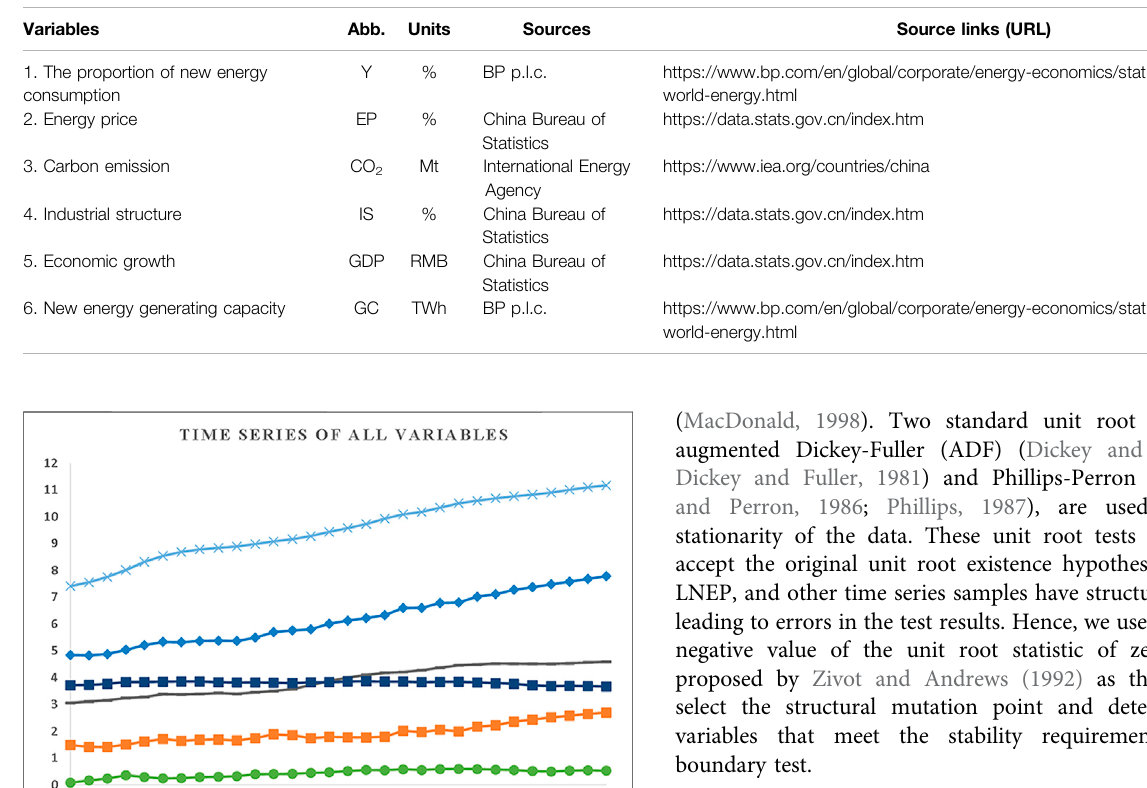
TABLE 1 | Data description and sources.